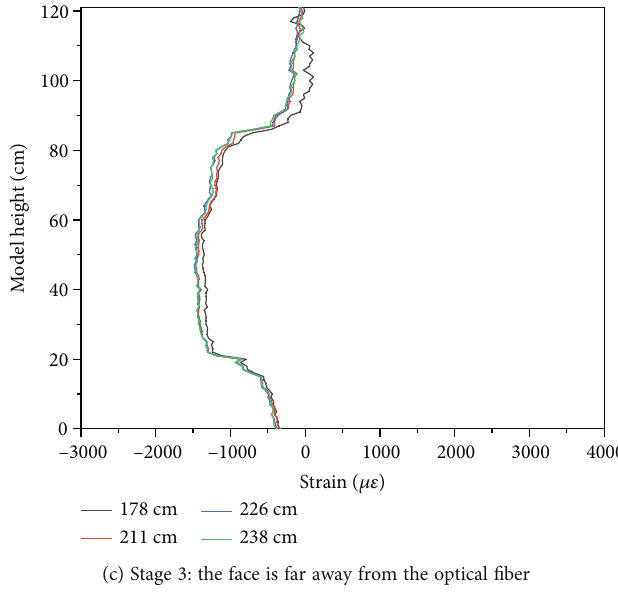
Figure 7: Strains of vertical fi ber V1 at di ff erent positions relative to the